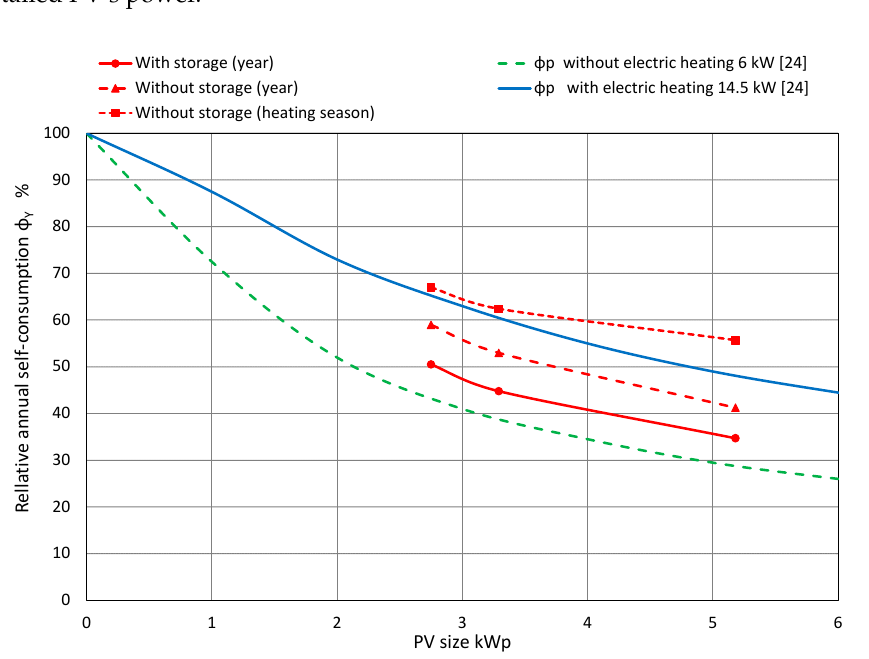
Figure 18. Comparison of relative self-consumption to average self-consumption, with and without load shifting and for different PV system sizes [12]. 6. Summary and Conclusions The increasing generation from the PV, especially in suburban areas, raises increasingly frequent problems, such as switching off the PV due to overvoltage. Such incidents were observed many times in the PVS of the studied building. This problem is growing in Poland, because over the last two years the capacity of prosumer PV generation has doubled annually. Currently, DSOs have no control over the installations up to 10 kWp. One way to absorb large amounts of energy is through the use of HPs. These can significantly increase the stability of the grid if the DSOs provide the DSR. Another solution that could be implemented is energy storage. From the point of view of use, the EESS is the more